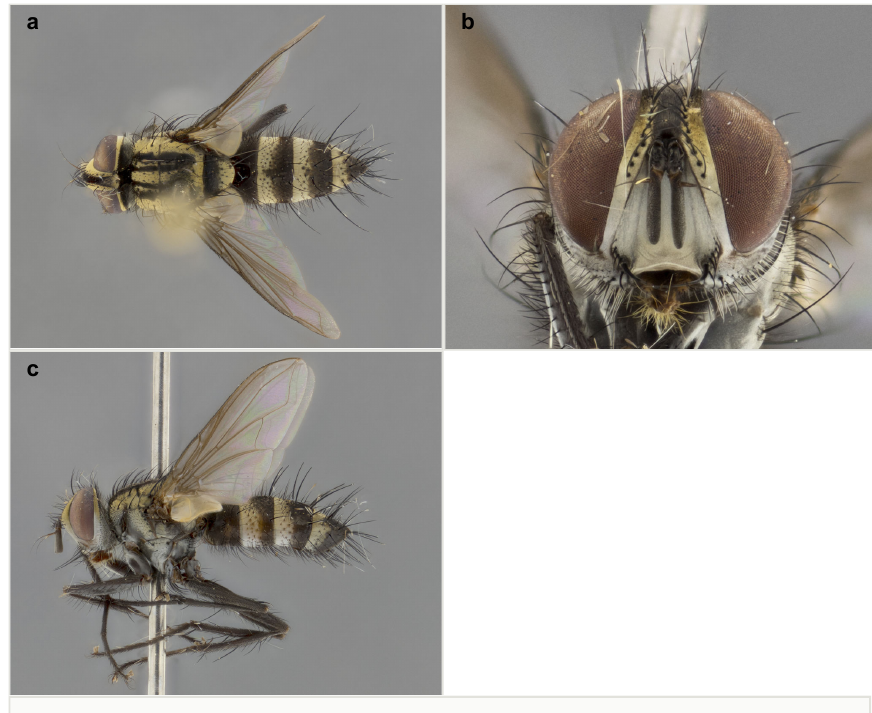
Female : not known at this